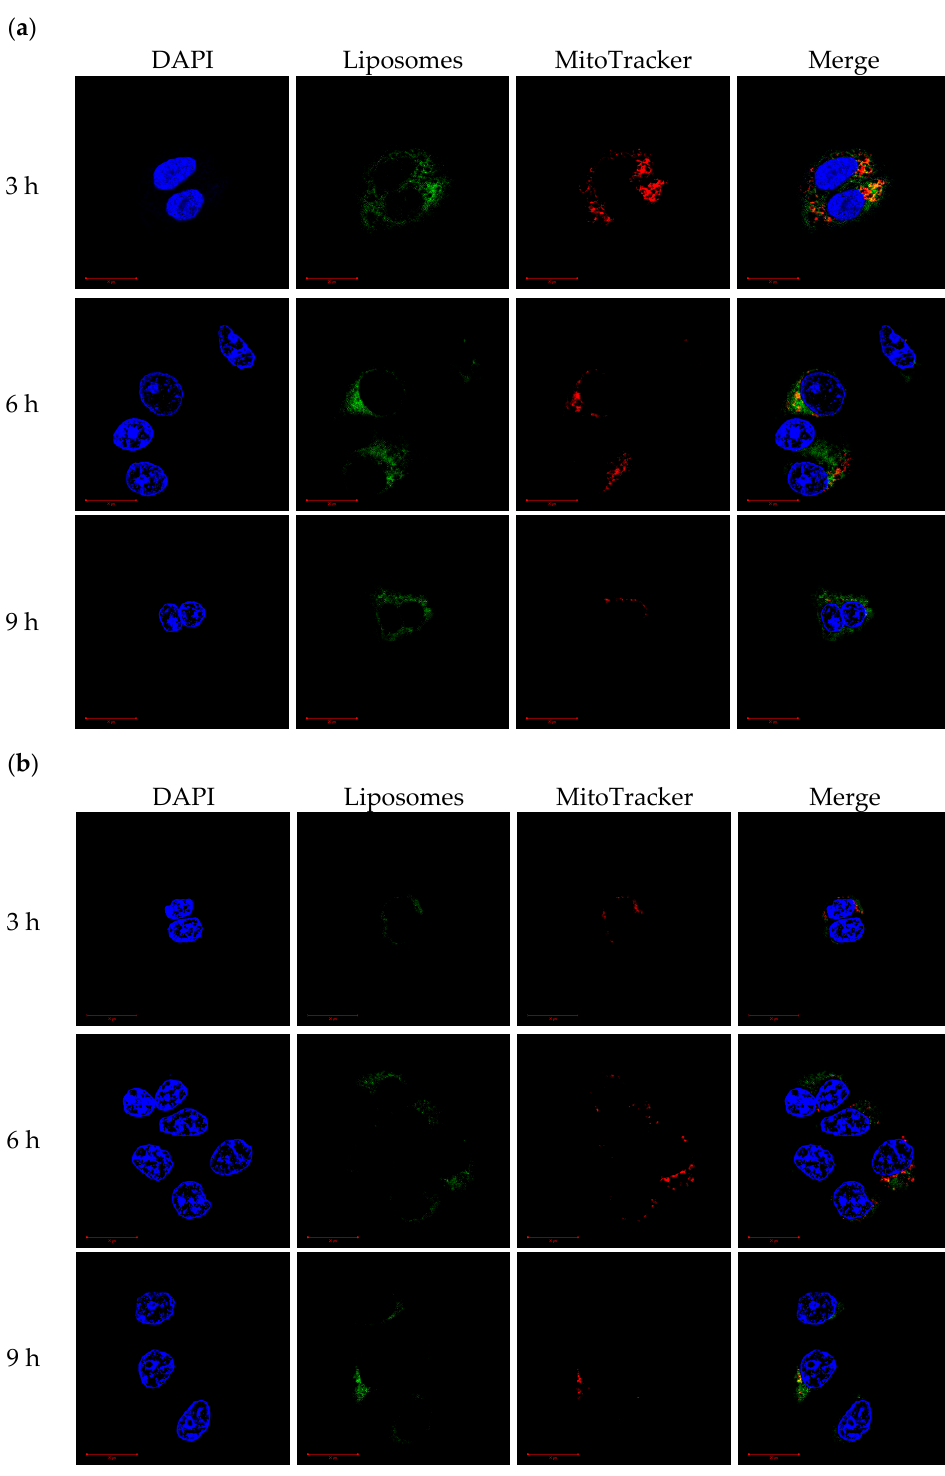
Figure 8. Mitochondrial-targeting ability of polymer–liposome complexes. Confocal images of ( a ) PCLH and ( b ) PCLM after co-incubation with MCF-7 cells for 3, 6, and 9 h. Scale bar: 20 μ m ( n = 3, showing one of the measurements from the data).